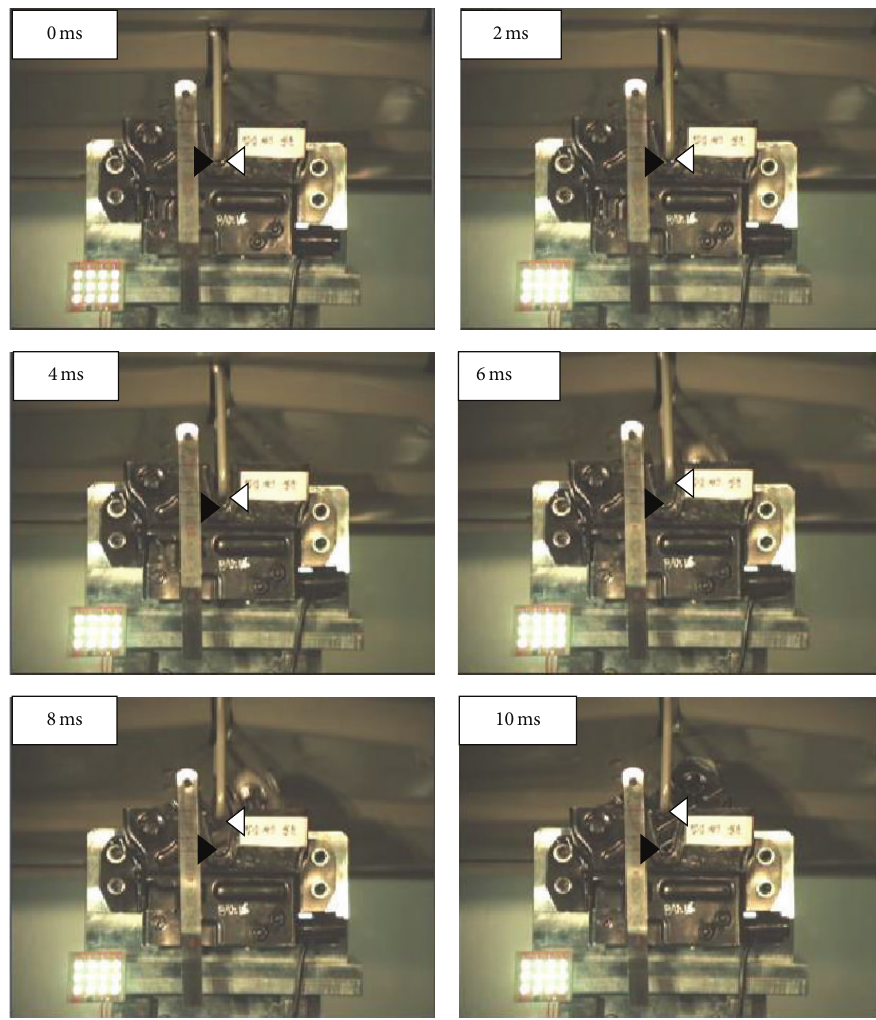
Figure 4: Sequence photographs of performance evaluation test at 35 MPa MGG.